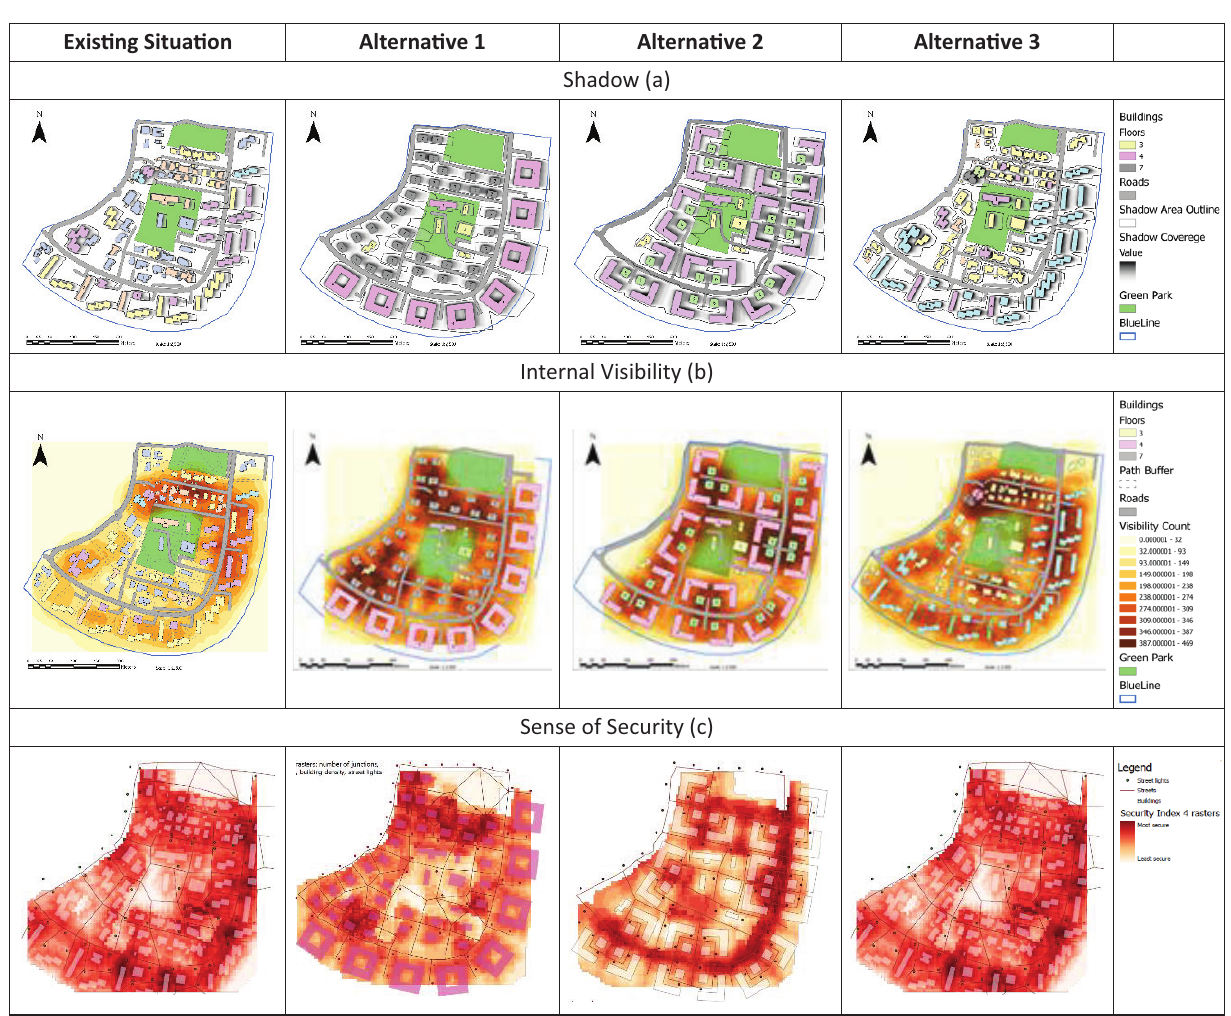
Figure 7. Noon hours of the average hottest days (15th July and 15th August, 11 am and 4 pm): (a) shadow analysis, (b) Internal visibility (eyes on the street); and (c) sense of security based on the SRI (Shach‐Pinsly,